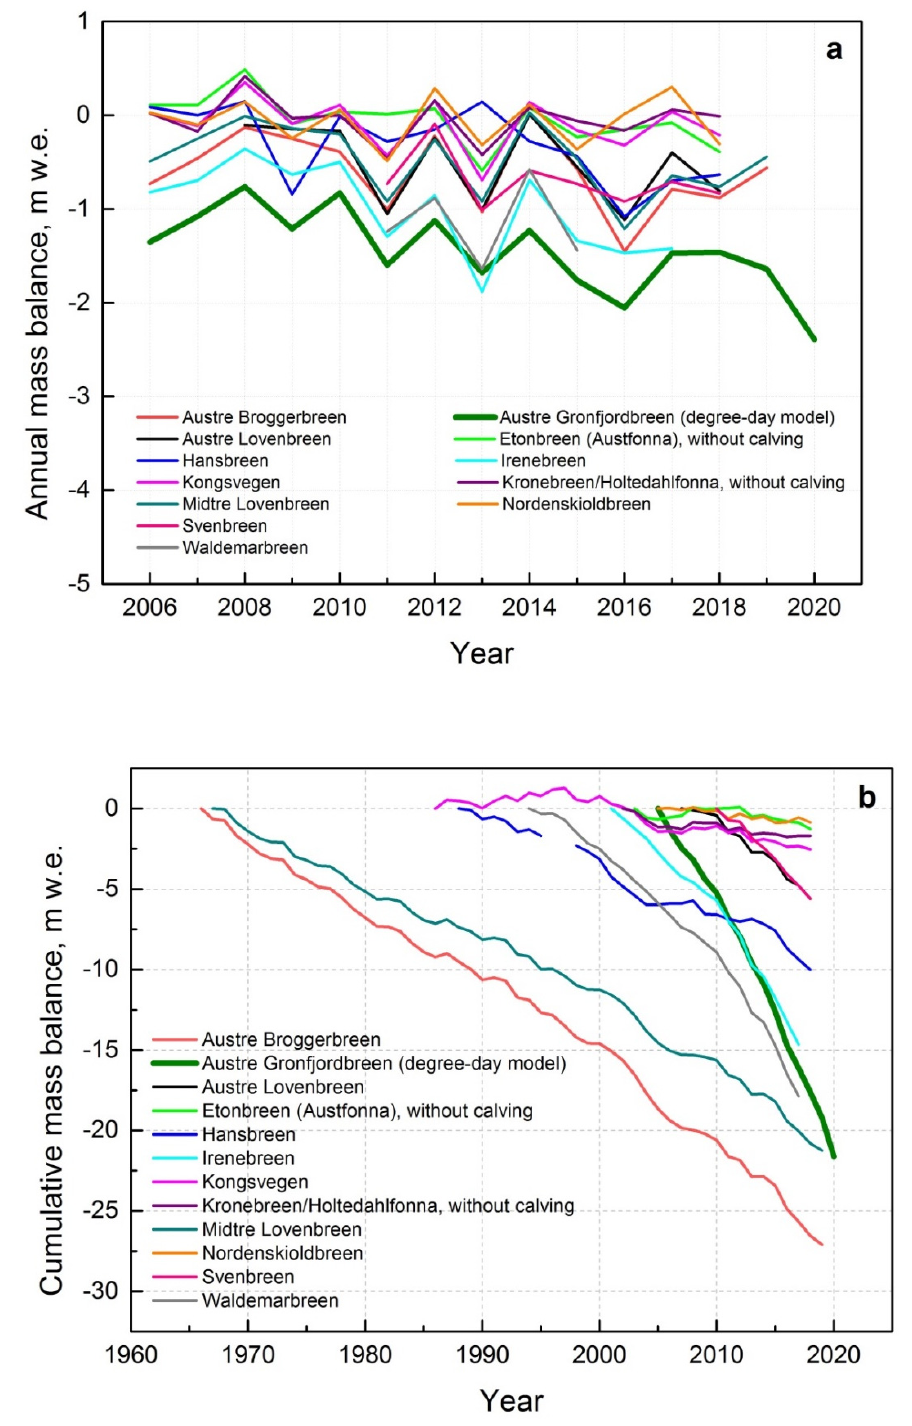
Figure 12. ( a ) The net balance throughout the monitoring periods for 12 glaciers including modelled annual mass balance of Austre Grønfjordbreen; ( b ) the cumulative mass balance throughout the monitoring periods for 12 glaciers modified from Schuler et al. [10,39] .